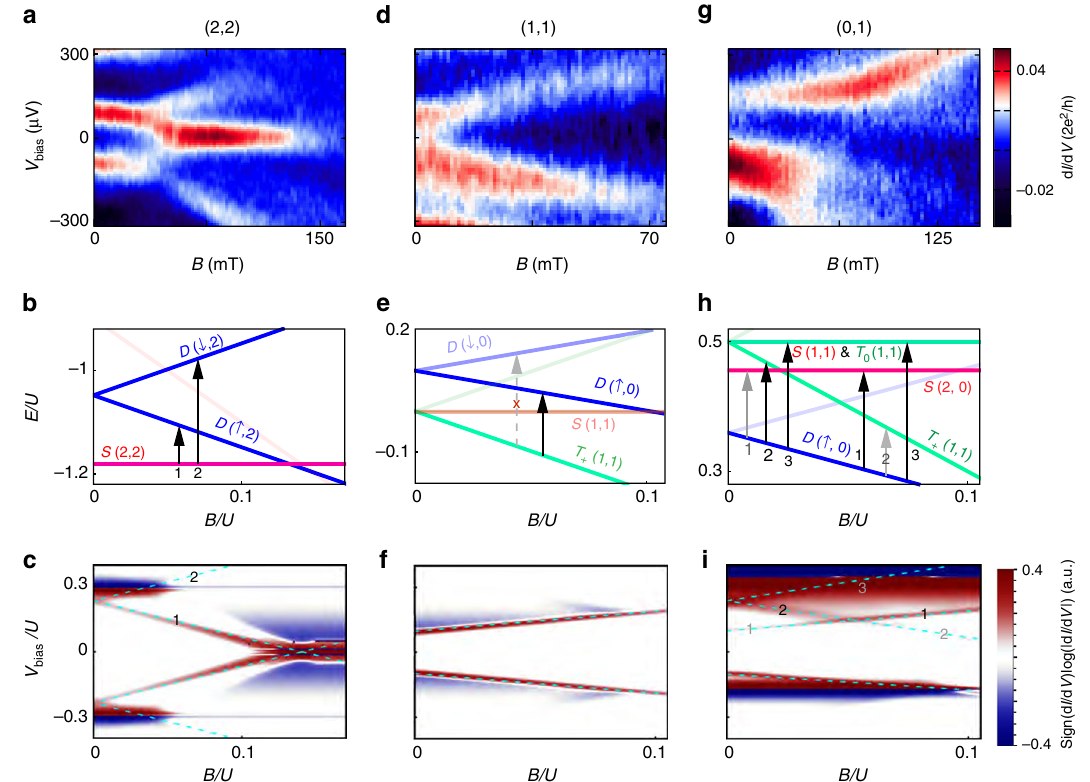
Fig. 4 Magnetic fi eld evolution of Andreev molecular states. a , d , g Bias spectroscopy of Andreev resonances as a function of magnetic fi eld for (2,2), (1,1) and (1,0) double dot con fi gurations. S(2,2) denotes singlet (2,2) con fi guration. b , e , h Numerically computed spectra of Andreev molecular states as a function magnetic fi eld for V bias = 0. The black ( gray ) arrows and numbers label the allowed transitions in the simulated spectra ( b , e , h ) and the associated high ( low ) conductance resonances in the numerical d I /d V transport plots ( c , f , i ). In e the crossed dashed arrow labels the forbidden transition between T + (1,1) and D ( ↓ ,0). The light blue dashed lines in c , f , i plot the bias voltage at which the levels on the dots come into resonance. The d I /d V plots use the same model parameters as in the spectrum